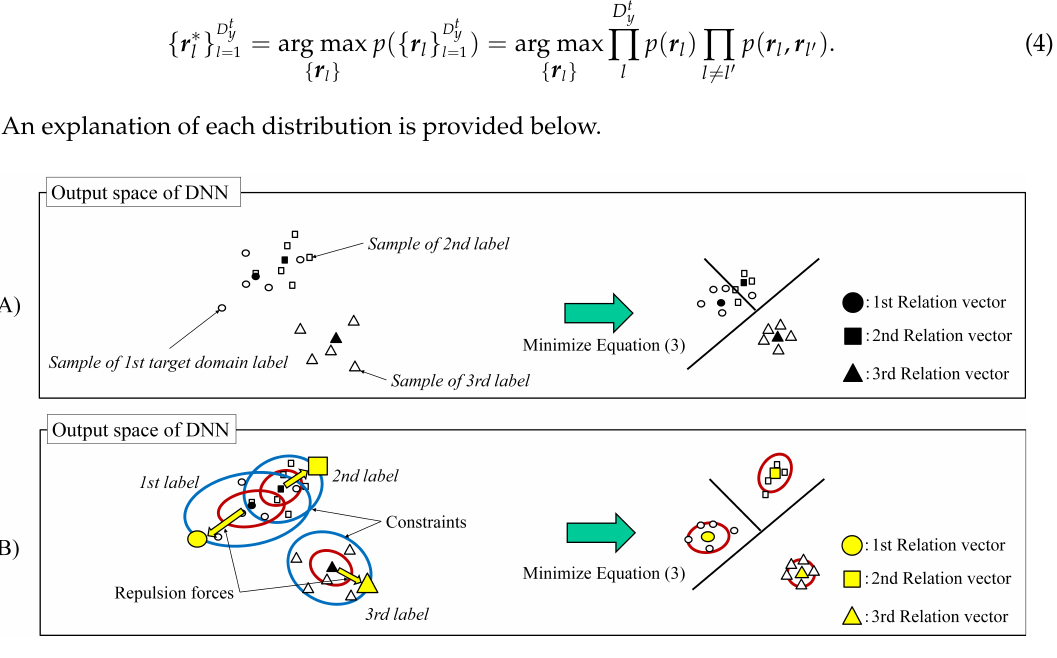
Figure 2. Overview of the relation between relation vectors. ( A ) Previous ATDL and ( B ) our method. By using our relation vector modification, the distance between the relation vectors increases without the risk of